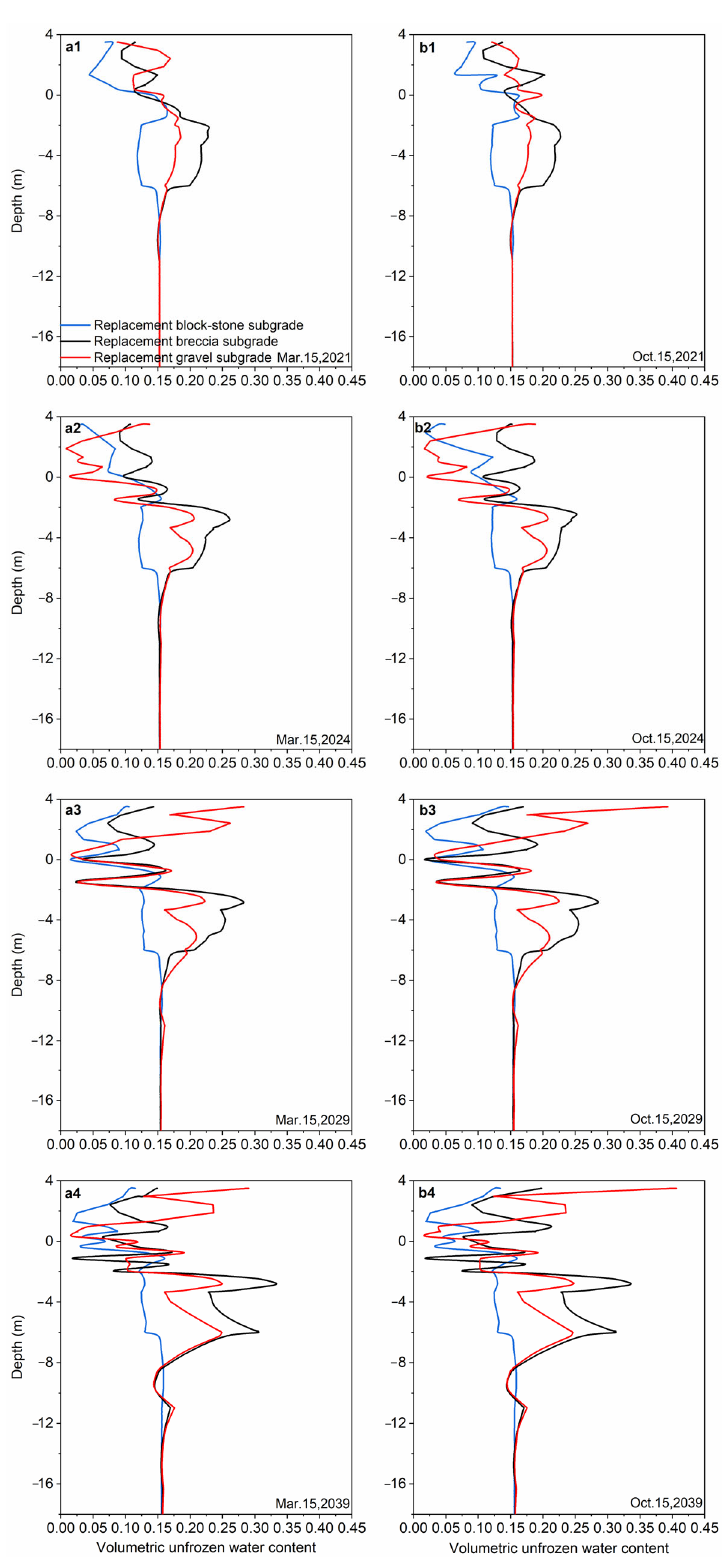
Figure 10. Vertical distribution of the volumetric liquid water content under the road centerlines of the three subgrade structures in different years: ( a1 – a4 ) in cold seasons and (b1 – b4 ) in warm seasons.